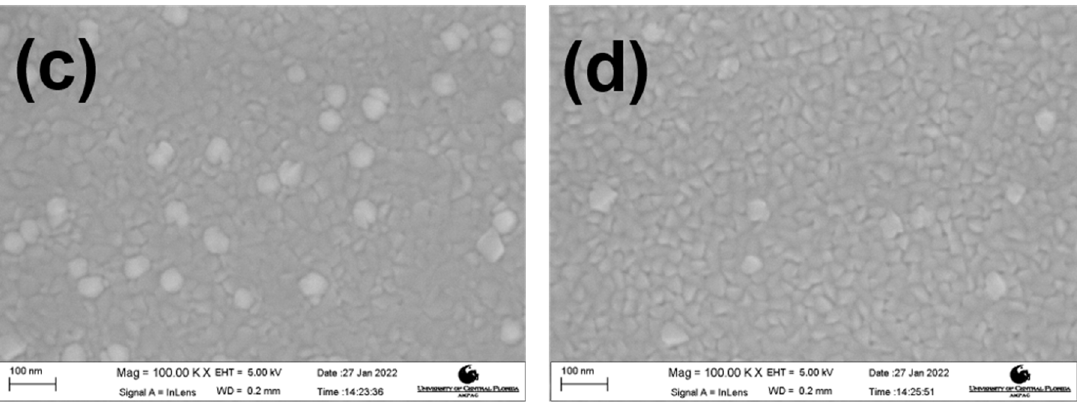
Figure 3. SEM images of CuInO x films on quartz: ( a ) room temperature, ( b ) substrate temperature of 200 °C, ( c ) substrate temperature of 300 °C, ( d ) substrate temperature of 400 °C.